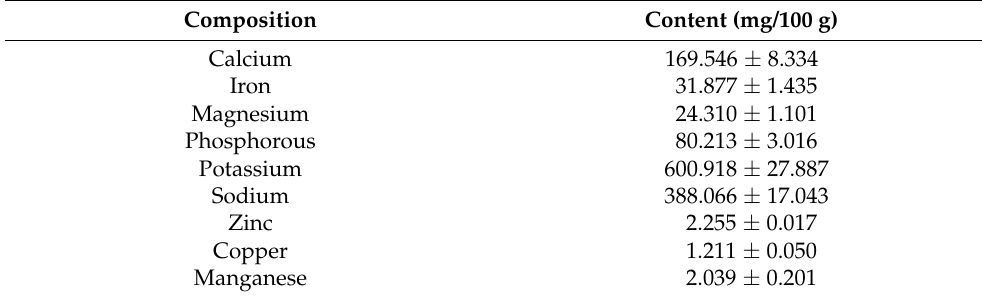
Table 2. Analyzed mineral composition of sea buckthorn